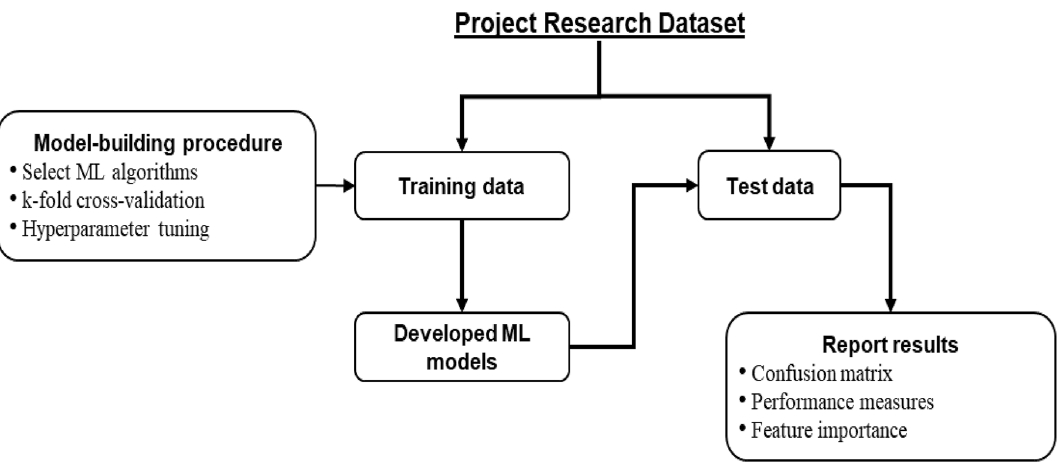
Figure 3. The proposed machine learning-based data-driven